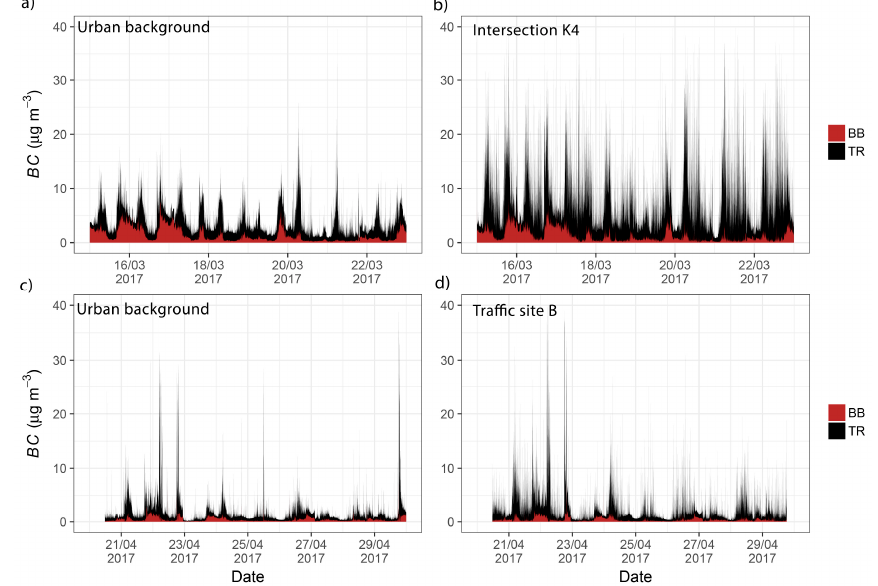
Figure 5. Time variation of black carbon (BC) concentration apportioned to traffic (TR) and biomass burning (BB) during two measurement campaigns in March 2017 ( a , b ) and in April 2017 ( c , d ), measured simultaneously at the background location—A ( a , c ) and close to the street intersection K4 ( b ) and traffic site B ( d ).